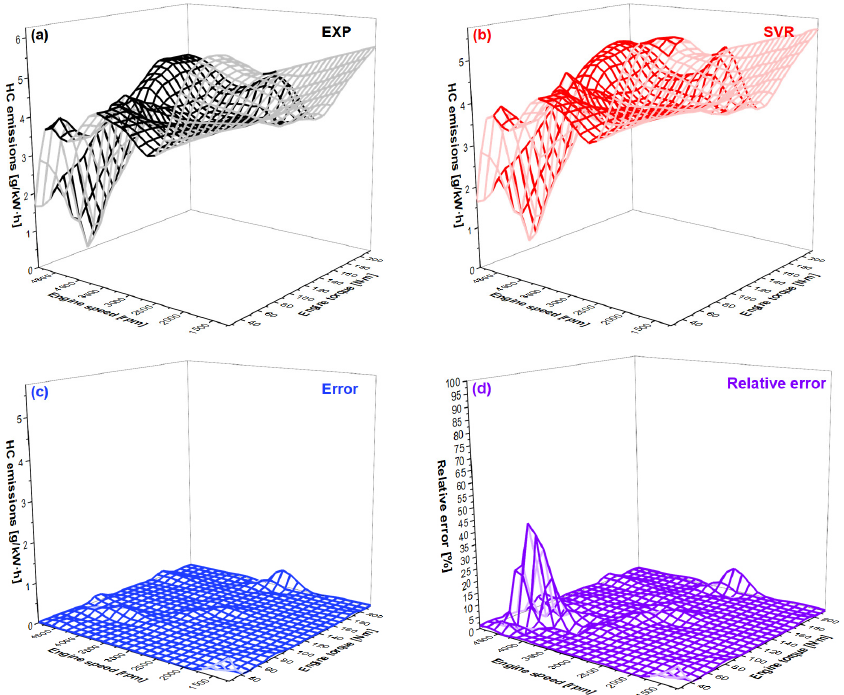
Figure 12. Comparison of SVR-predicted and experimental HC-emissions-established engine map.